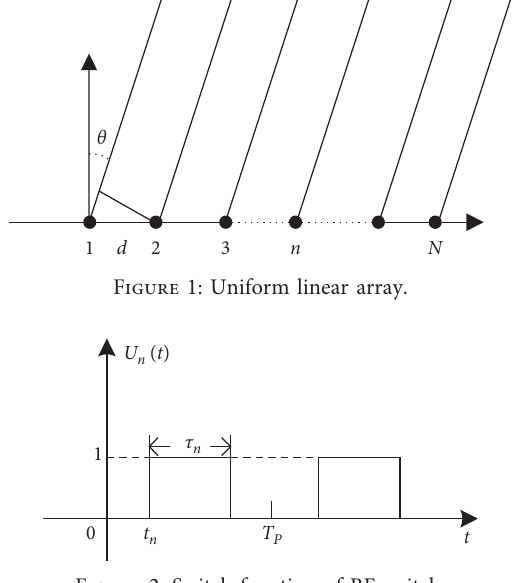
Figure 2: Switch function of RF The constraints on the center frequency band and